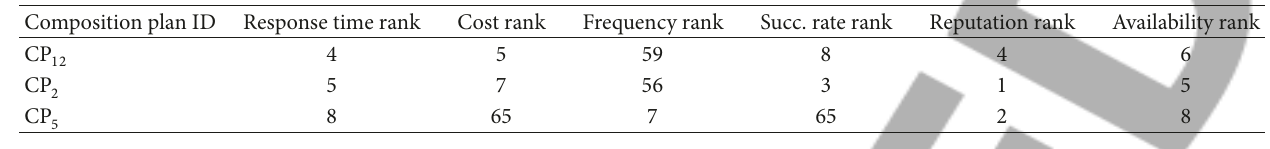
Table 6: List of web